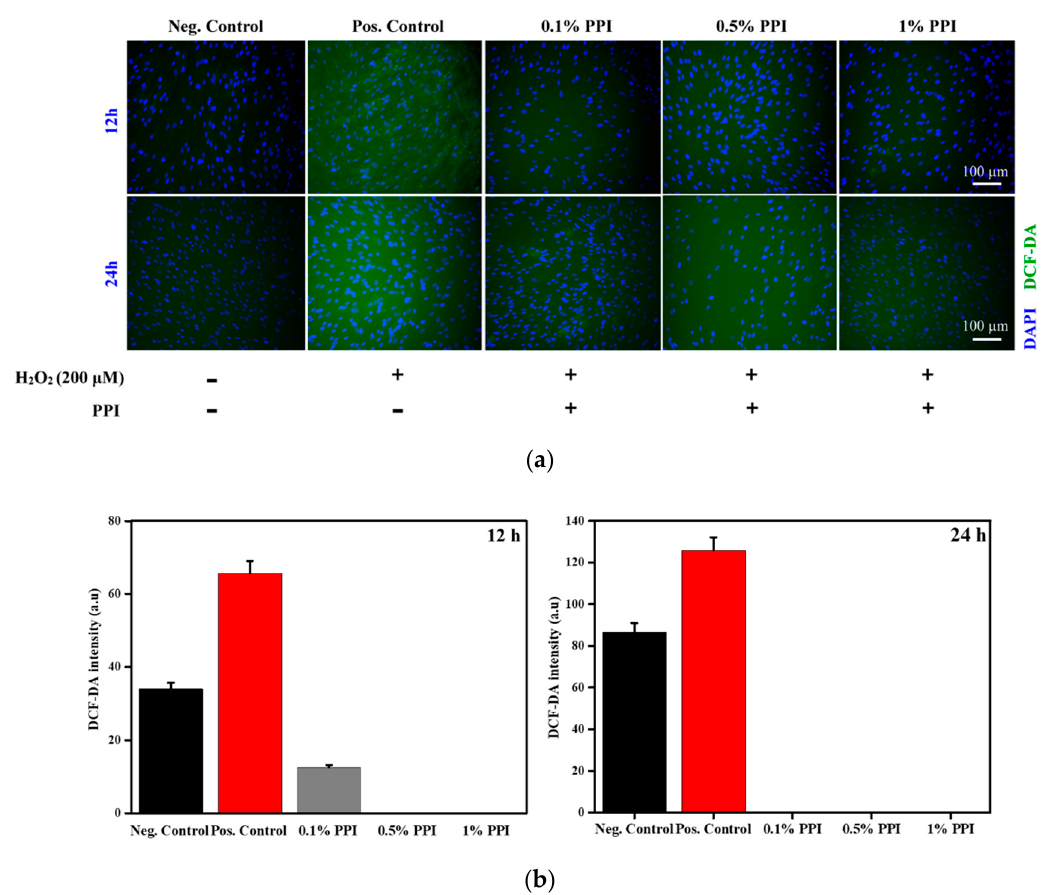
Figure 7. Assessment of the ROS scavenging potential of PPI under H 2 O 2 -induced oxidative stress. ( a ) DCF-DA staining at indicated time intervals, and ( b ) the respective image-based ROS measurement.